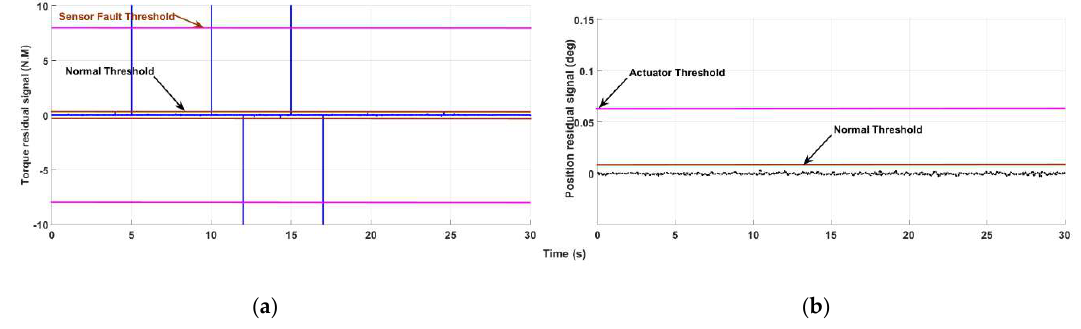
Figure 14. Normal condition residual signals: ( a ) torque and ( b ) joint position variable.